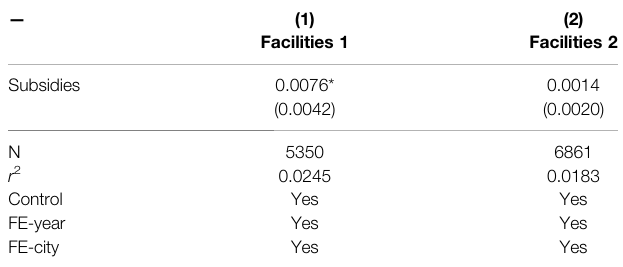
TABLE 10 | Pollution prevention and control strategies. —